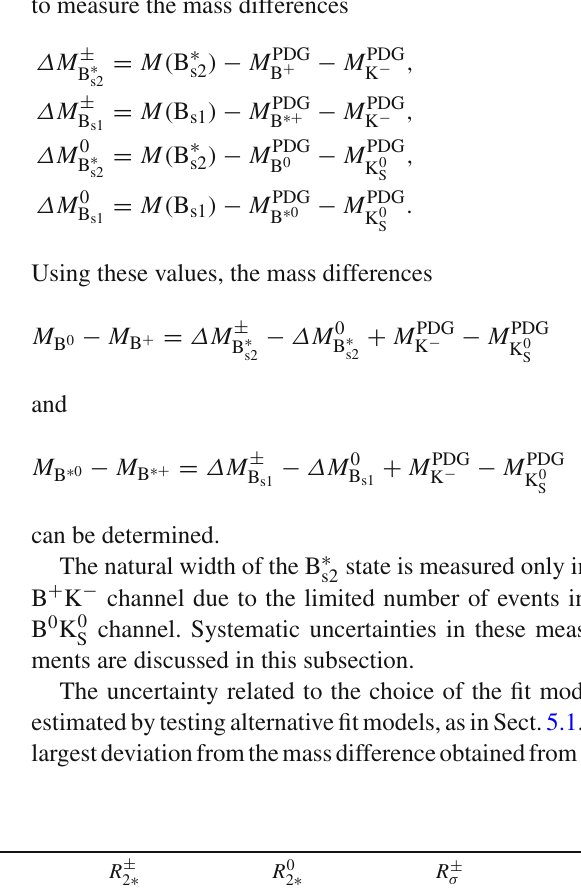
uncertainties in percent in the ratios R ± , R 0 , R ± σ , and R 0 2 ∗ 2 ∗